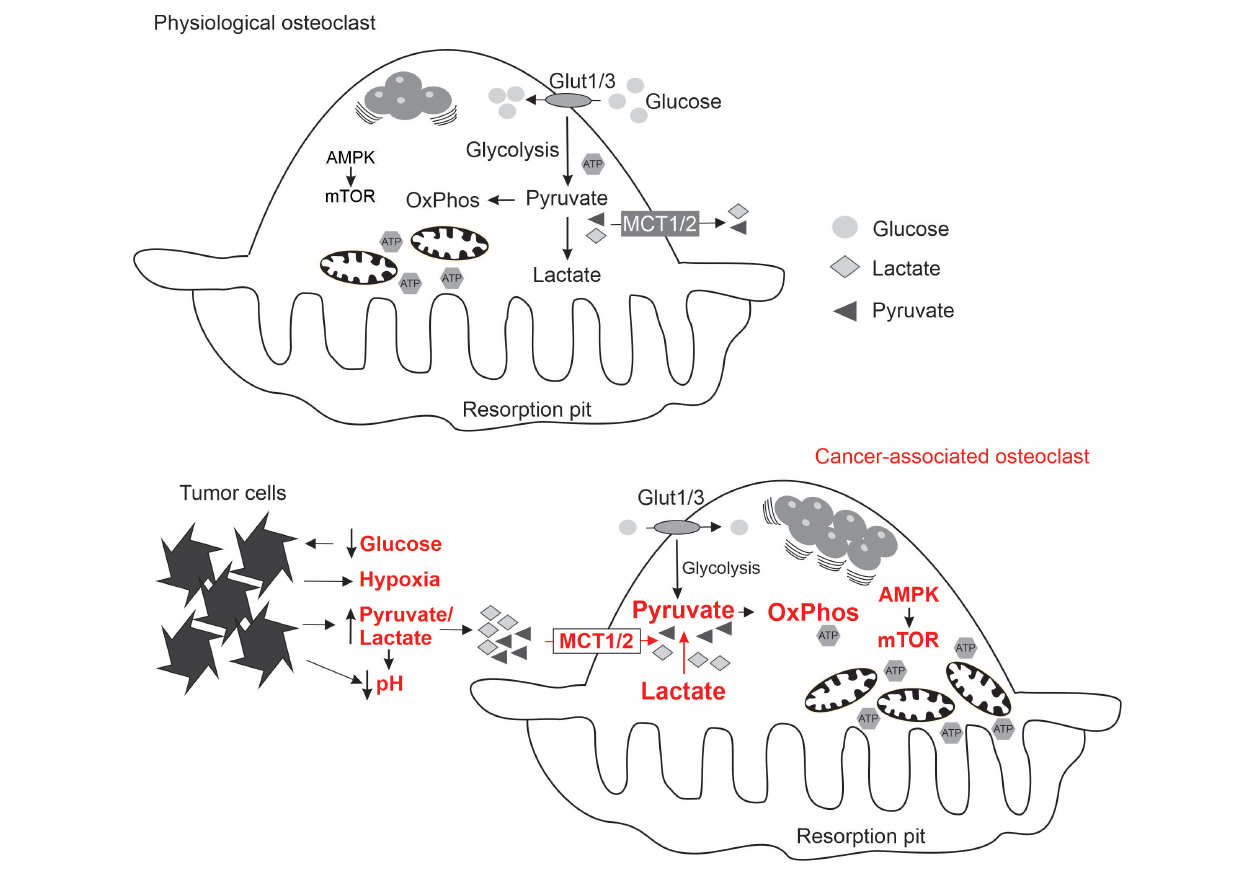
FIGURE 1 | Schematics summarizing the state of energy metabolism in osteoclasts formed under physiological conditions (top), and the adaptive changes in osteoclasts (indicated in red) exposed to the local microenvironment modified by metastasizing cancer cells